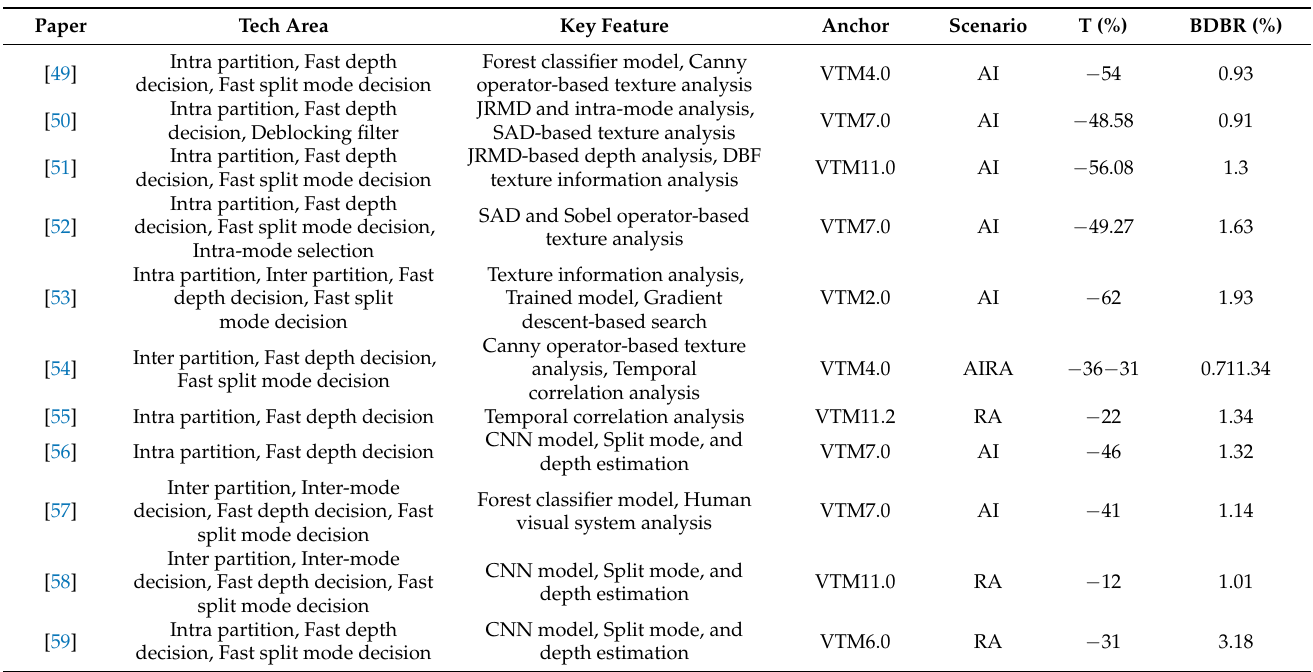
Table 2. Summary of fast methods on early CU depth